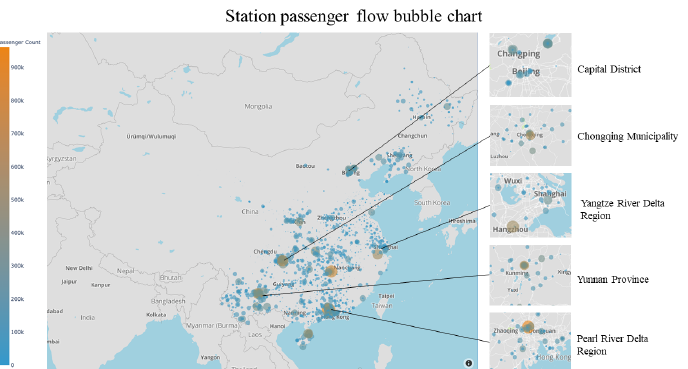
Figure 8. Station distribution map. The size and color of the bubble indicate the amount of the passenger flow. The orange bubble indicates that the passenger flow of the station is large, and the blue is low. Most of the bubbles are concentrated in Yangtze River Delta, the Pearl River Delta, Beijing, Chongqing, and Yunnan Province. There are several prominent big and orange bubbles in Guangzhou, Changsha, Kunming and Hangzhou, indicating that the passenger flow of these stations is much higher than that of other